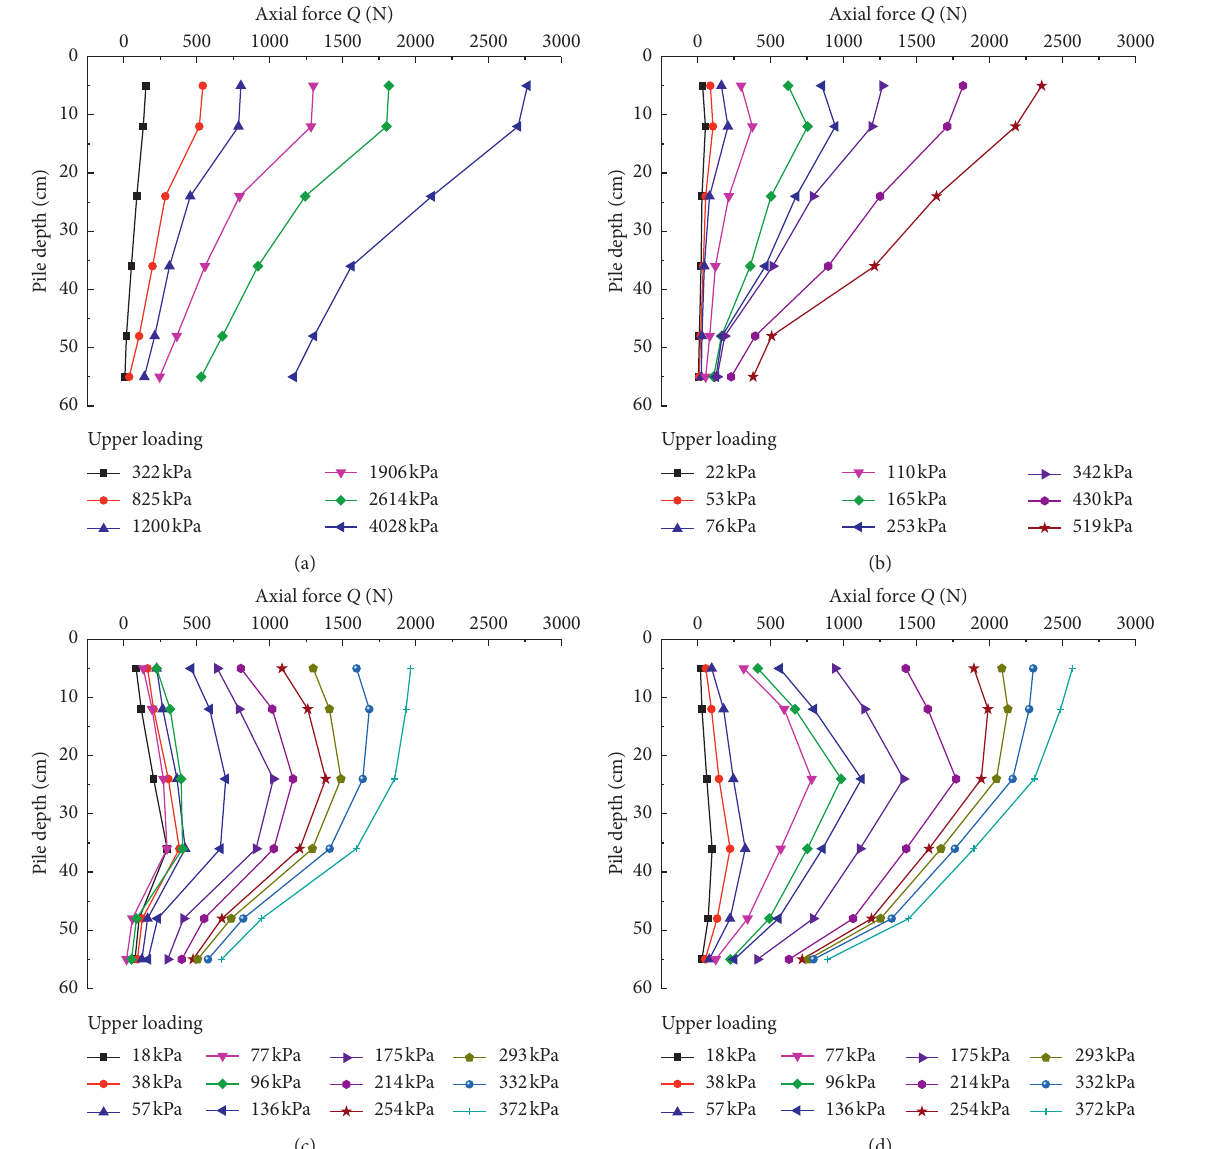
Figure 6: Variations of pile axis stress with the change of depth and upper load in different model tests. (a) Y-1 single pile, (b) Y-2 single pile composite foundation, (c) Y-3 group pile composite foundation (Middle pile), and (d) Y-3 group pile composite foundation (side